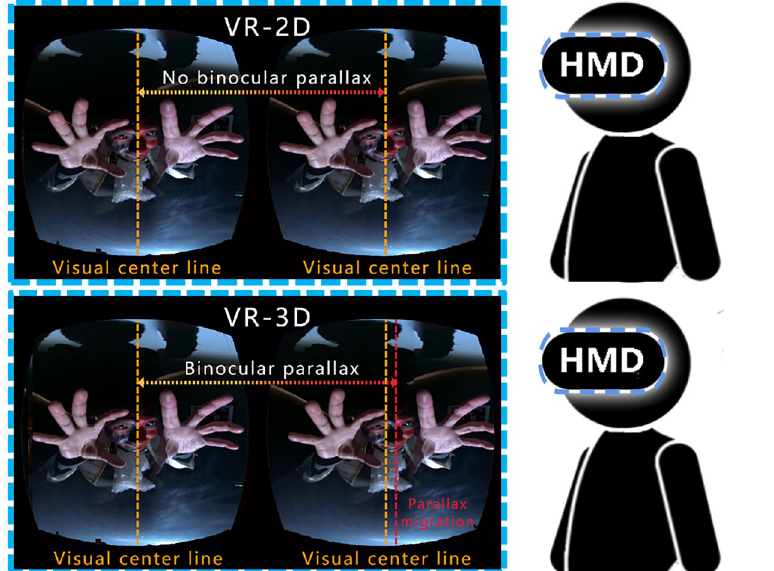
Fig 1. Comparison of internal helmet images in VR-2D and VR-3D